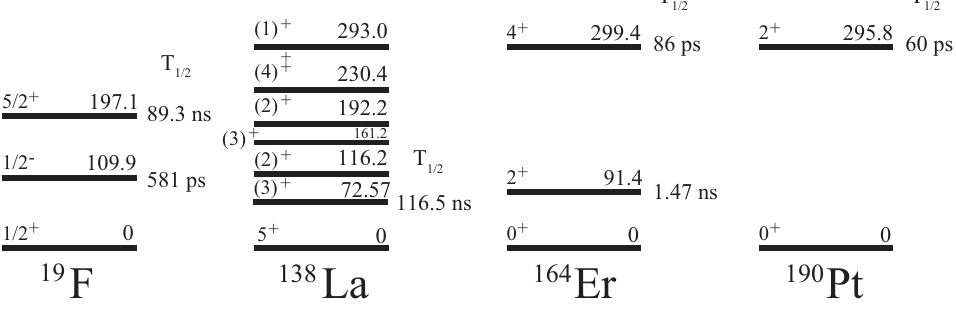
Figure 7. Partial level schemes of 19 F, 138 La, 164 Er, and 190 Pt. The states with excitation energies lower than 300 keV are presented. Time indicates the half-lives of excited